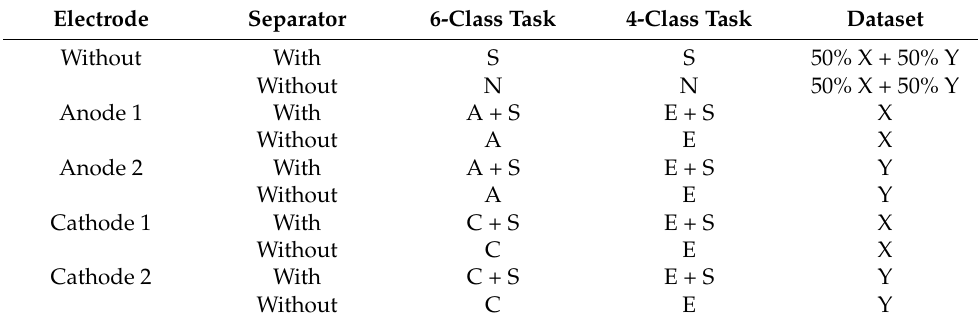
Table 2. Class labels for six-class and four-class classification task.